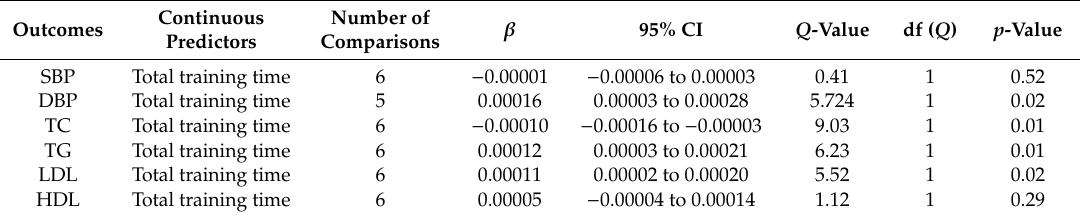
Table 4. Moderator analysis for the e ff ects of Wuqinxi versus control intervention (continuous predictor).